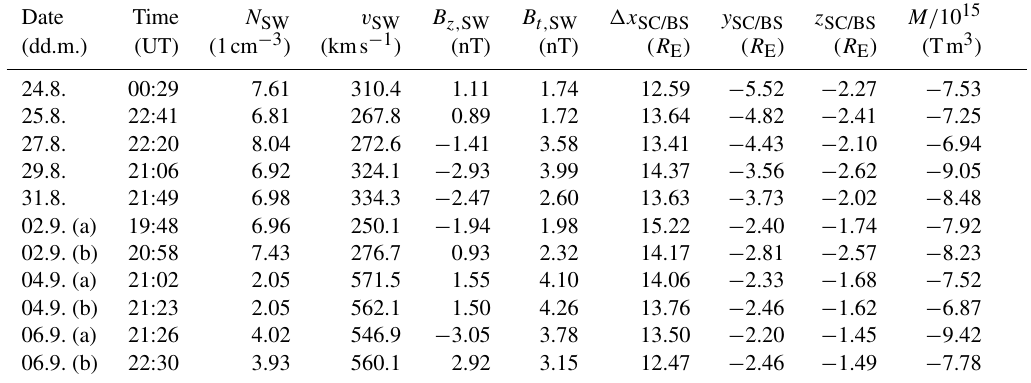
Table 1. Bow shock locations close to the subsolar point and the corresponding solar wind conditions observed by THC. The z component of solar wind magnetic field is B z, SW and the magnetic field magnitude in the yz plane is B t, SW = (B 2 moments are also